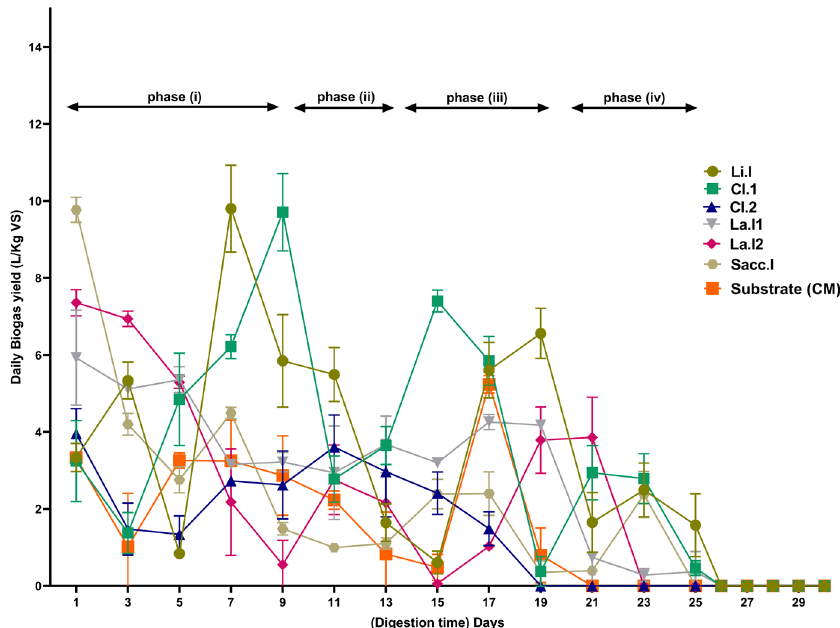
Figure 2. Daily biogas production from anaerobic digestion of cattle manure (CM) using various inoculum types. Error bars represent the standard deviation from three measurements.